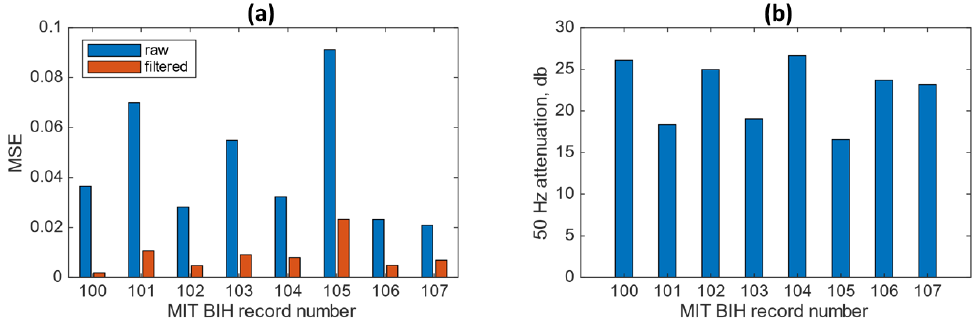
Figure 7. ( a ) MSE results applying the proposed denoising approach. ( b ) 50 Hz attenuation obtained from the MIT-BIH dataset records labelled m100 to m107.